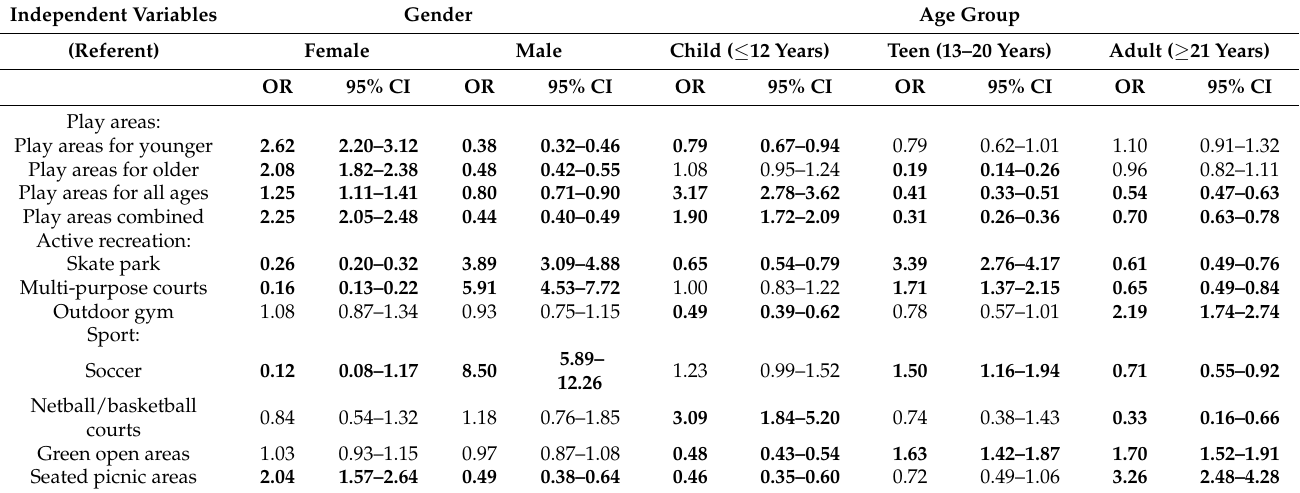
Table 8. Association between target area features and park use by demographic